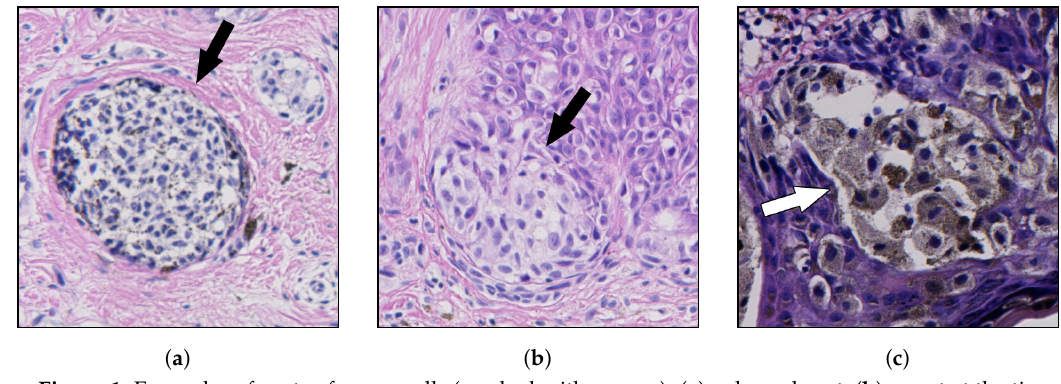
Figure 1. Examples of nests of nevus cells (marked with arrows): ( a ) a dermal nest; ( b ) a nest at the tip of a rete ridge; and ( c ) a nest adjacent to the epidermal plate; note a strong pigmentation of cytoplasm in nevus cells. The structure of nests is highly not-uniform and varies between individual